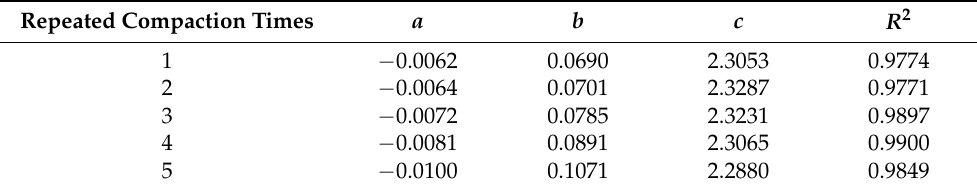
Table 5. Fitting results of fractal dimension and water